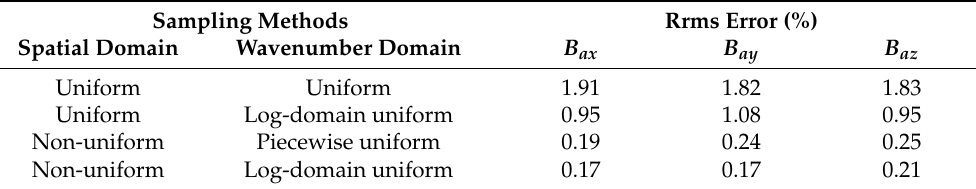
Figure 15. Spectral distribution of strong magnetic field in wavenumber domain (z = 250 m). Table 5. Accuracy statistics of different sampling points between − 0.25 and 0.25 in the